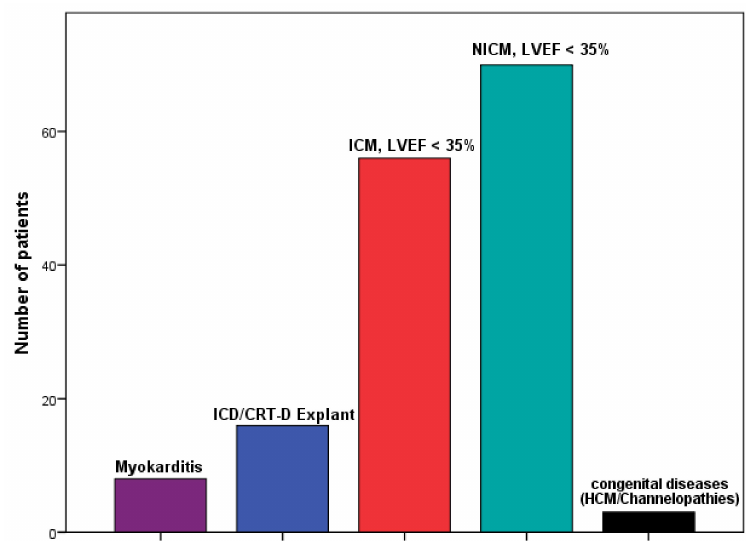
Figure 1. Distribution of the indication for wearable cardioverter-defibrillator (WCD) in a cohort of 153 patients according to opinion of physicians. ICD: implantable cardioverter defibrillator; CRT: cardiac resynchronization therapy; ICM: ischemic cardiomyopathy; NICM: non-ischemic cardiomyopathy; LVEF: Left ventricular ejection fraction; HCM: hypertrophic cardiomyopathy.